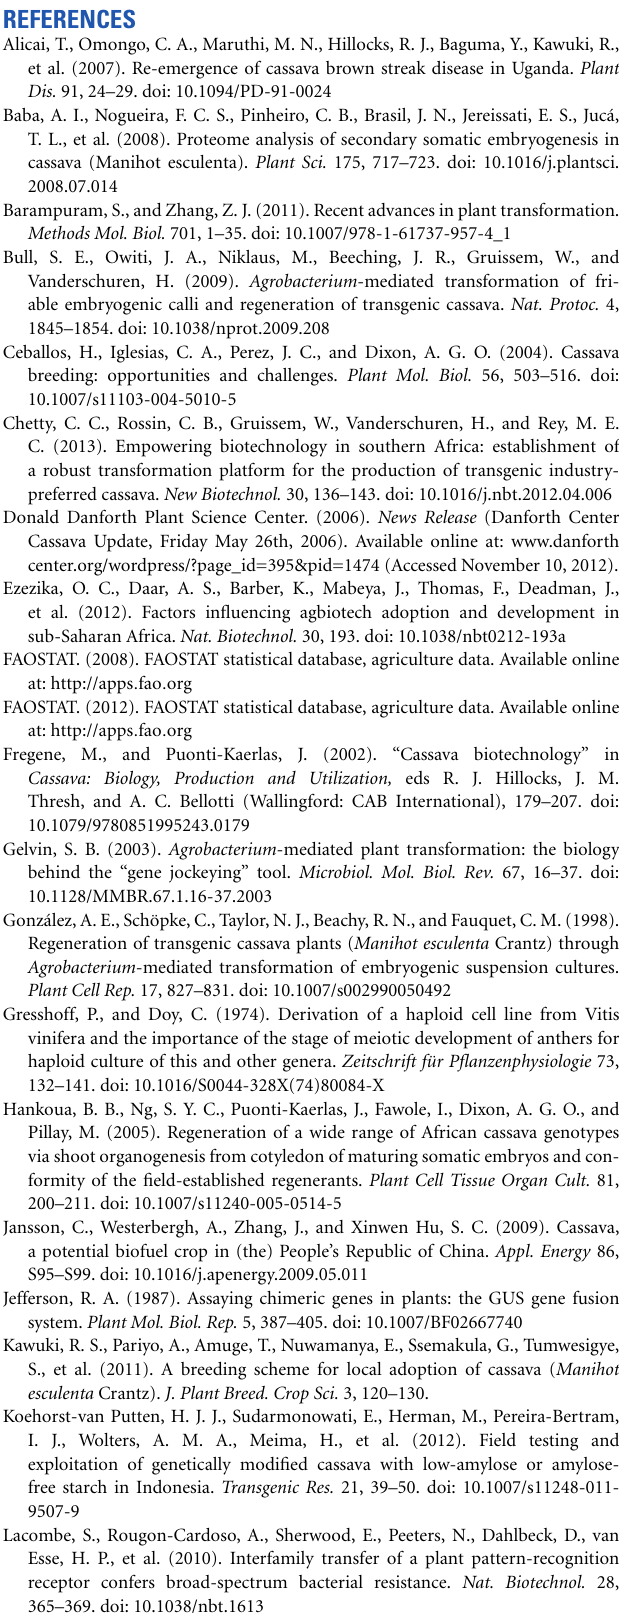
Table S1 | Composition of media used in tissue culture and transformation experiments. Figure S1 | Schematic representation of gene construct used for cassava transformation. The T-DNA region of construct pCAMBIA1301 with gus A and hpt genes. LB/RB, left/right T-DNA border sequences; CAMV35SP, CaMV 35S promoter; hpt , coding region of the hygromycin B resistance gene; npt II, coding region of the neomycin resistance gene; NOS, nopaline synthase; intron- gus A, β -glucuronidase containing intron. Arrows indicate direction of transcription. Figure S2 | Southern blot analyses of genomic DNA of transgenic lines restricted with Hind III using PCR-amplified product of gusA gene as a probe. M, DIG-labeled DNA marker; NT, non-transgenic plant; lanes 5, 20 and 22 are transgenic lines of cultivar 60444; 9, 10, and 12 are transgenic lines of cultivar Serere; 18 and 19 are, transgenic lines of cultivar